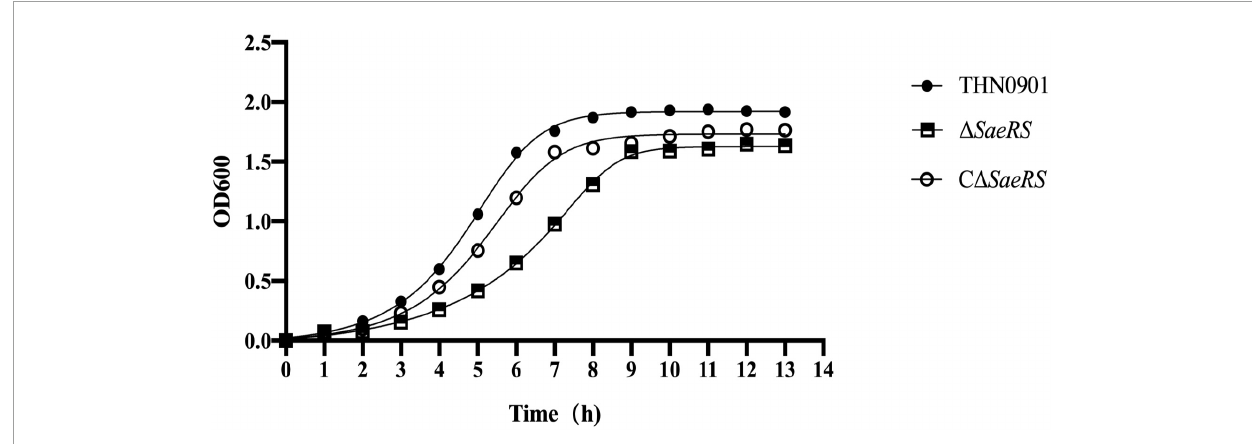
FIGURE2 Growth curve of S. agalactiae THN0901, (cid:49) SaeRS, and C (cid:49) SaeRS strains in brain heart infusion (BHI) medium. The growth curve was checked spectrophotometrically at 600 nm.